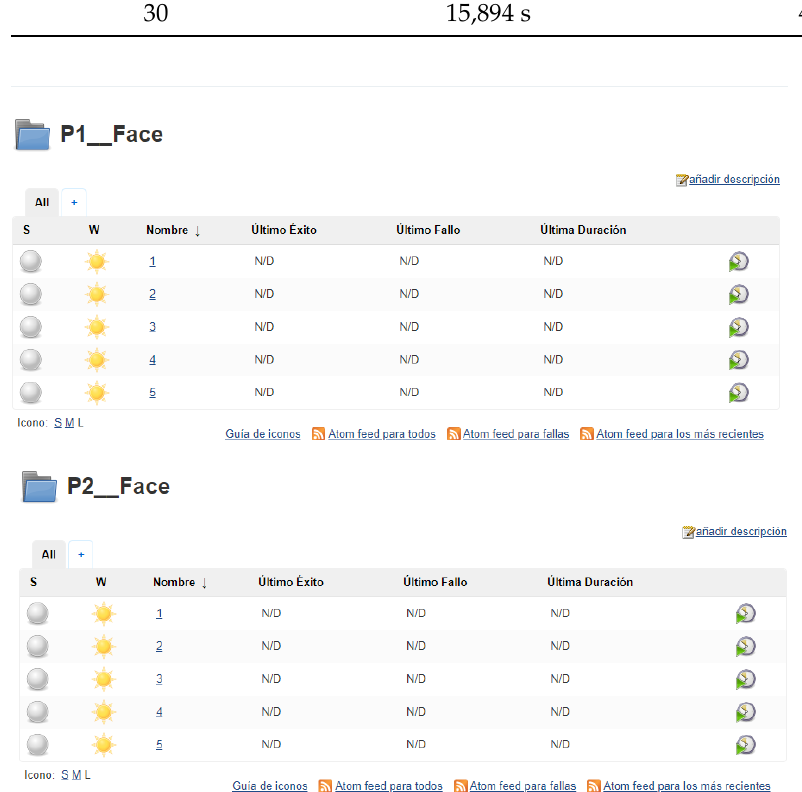
Figure 4. Jenkins view for the practice 1 ( top ) and practice 2 ( down ) which are composed of 5 exer-